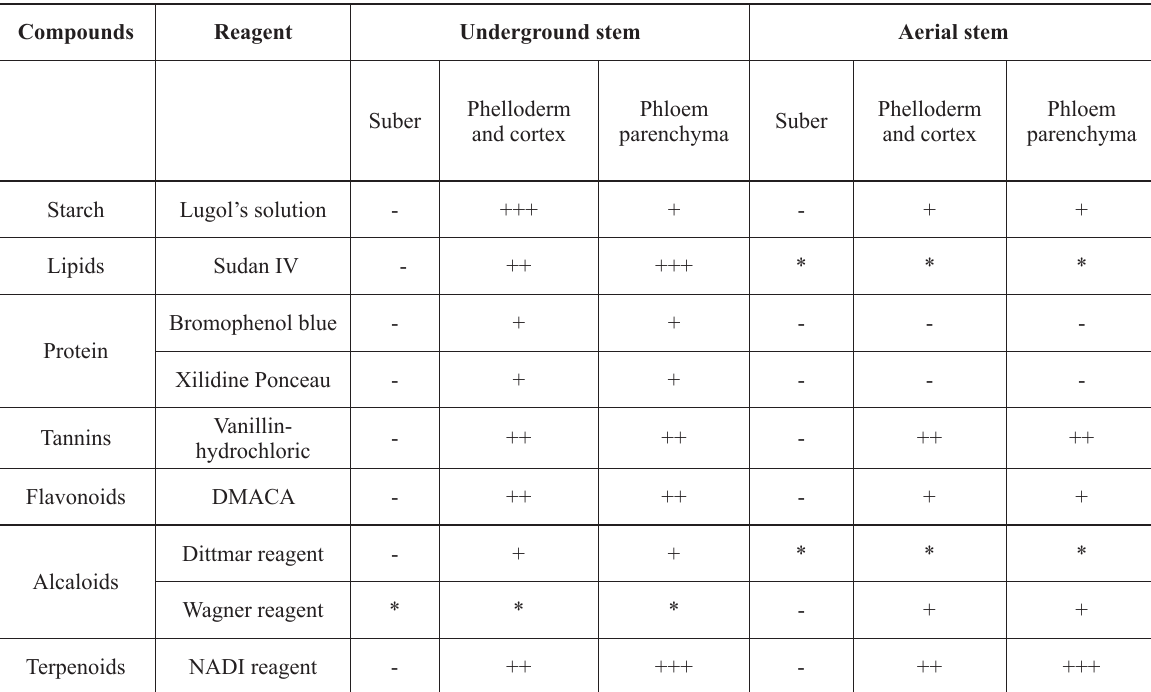
Results of the histochemical tests in the underground and aerial stems of T. micrantha . (+) presence; (-)